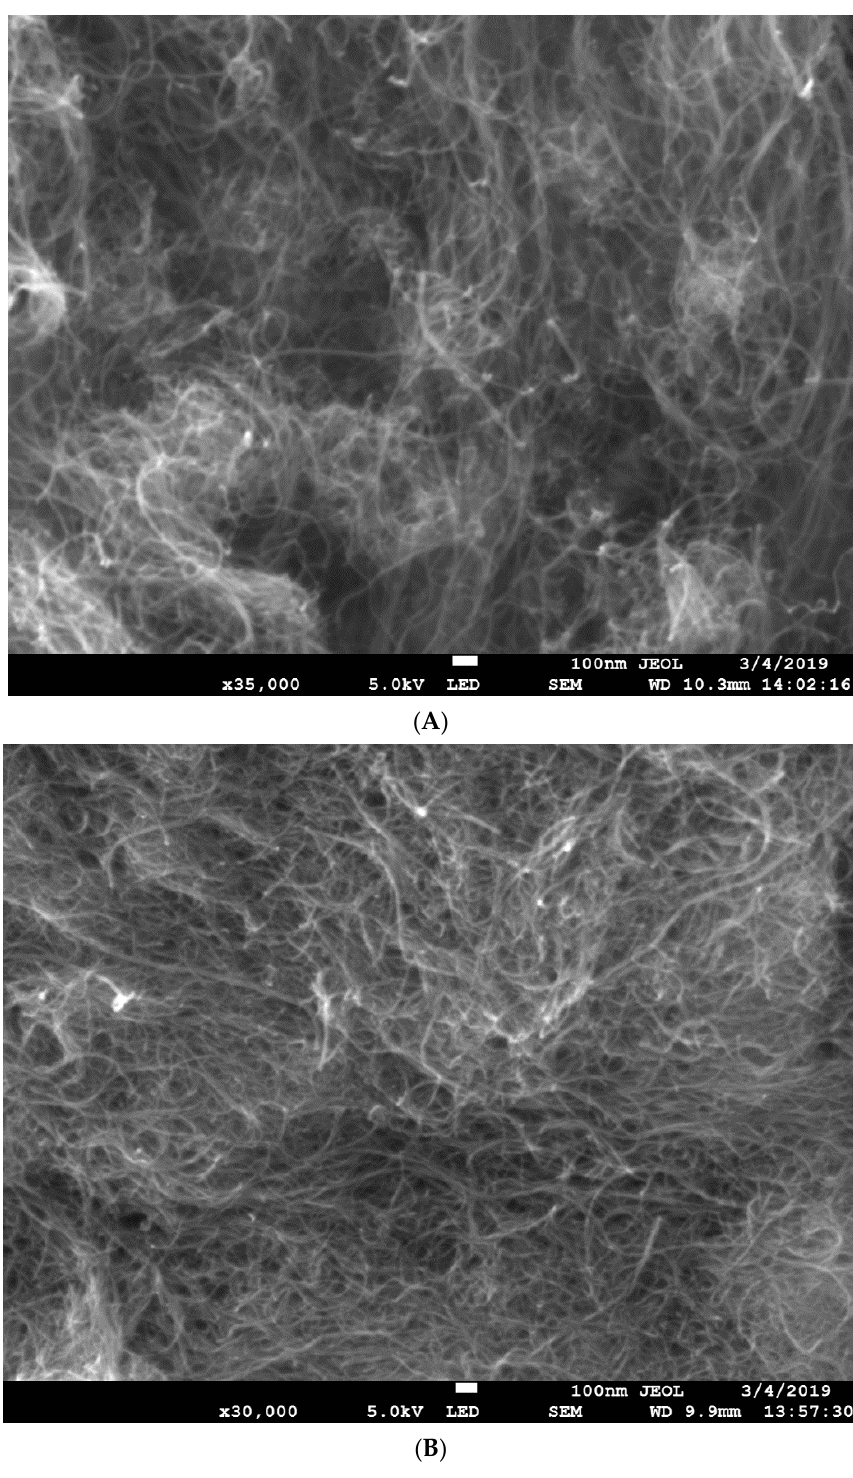
Figure 1. ( A ) As-received multiwalled carbon nanotubes (MWCNTs); ( B ) mill HNO 3 -functionalized MWCNTs (FMWCNTs).